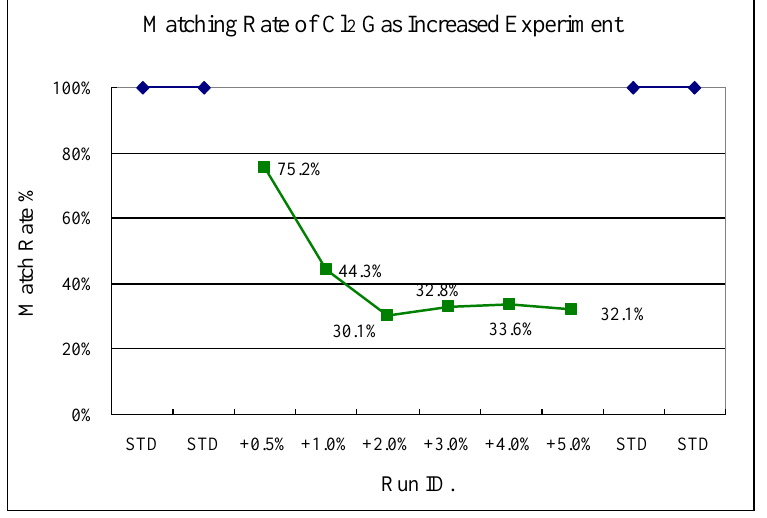
Figure 10. Experiment 1, Cl variance tested from 50.25 to 52.25 sccm [standard (STD) = 50 sccm]. 2 Matching Rate of Cl 2 Gas Increased